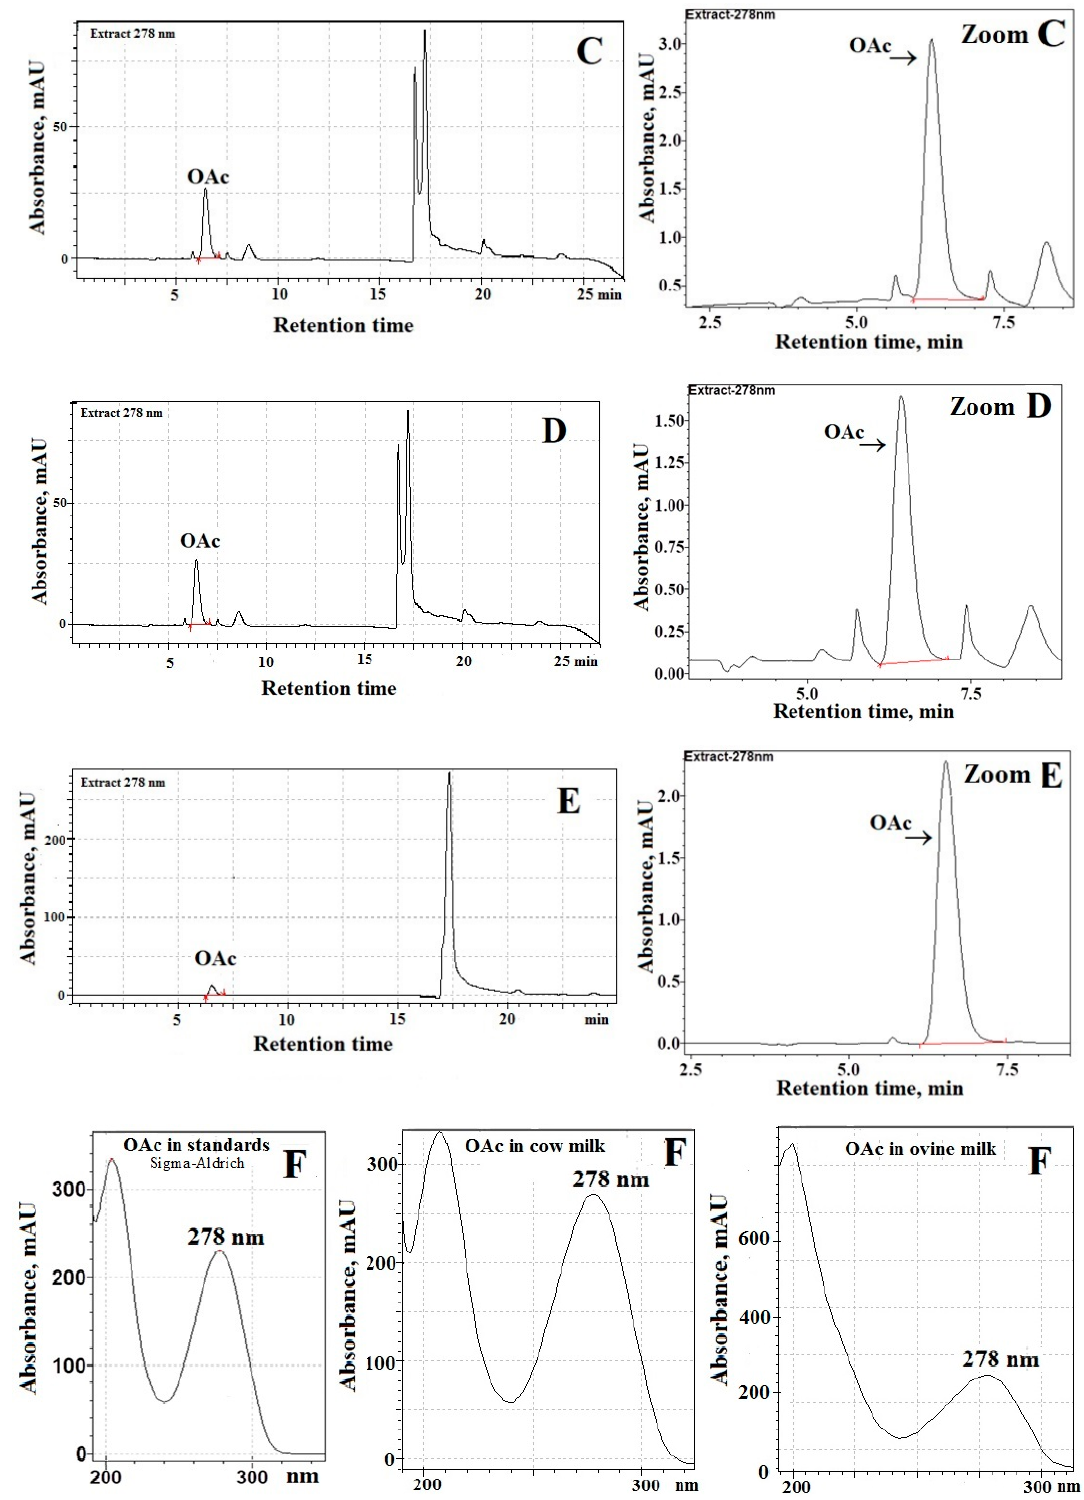
Figure 1. The typical chromatogram for ( A ) ovine milk samples using one analytical C 18 -column (an injection volume: 3 µL; a column temperature: 23 °C). Chromatographic separations by using two analytical C 18 -columns (injection volumes: 6 µL; a column temperature: 35 °C) for ( B )—ovine milk, ( C )—cow milk, ( D )—full-fat powdered cow milk, ( E )—OAc standard (0.015 mg/mL), ( F )—typical stop-flow UV absorbance spectrum of OAc in analyzed standards (Sigma-Aldrich) and milk of sheep and